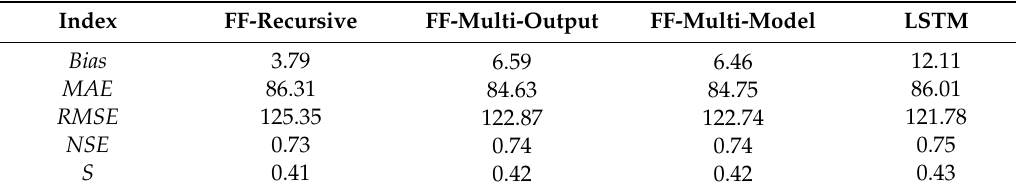
Table 4. Average performances of FF and LSTM predictors on the first 3 hours (daytime samples